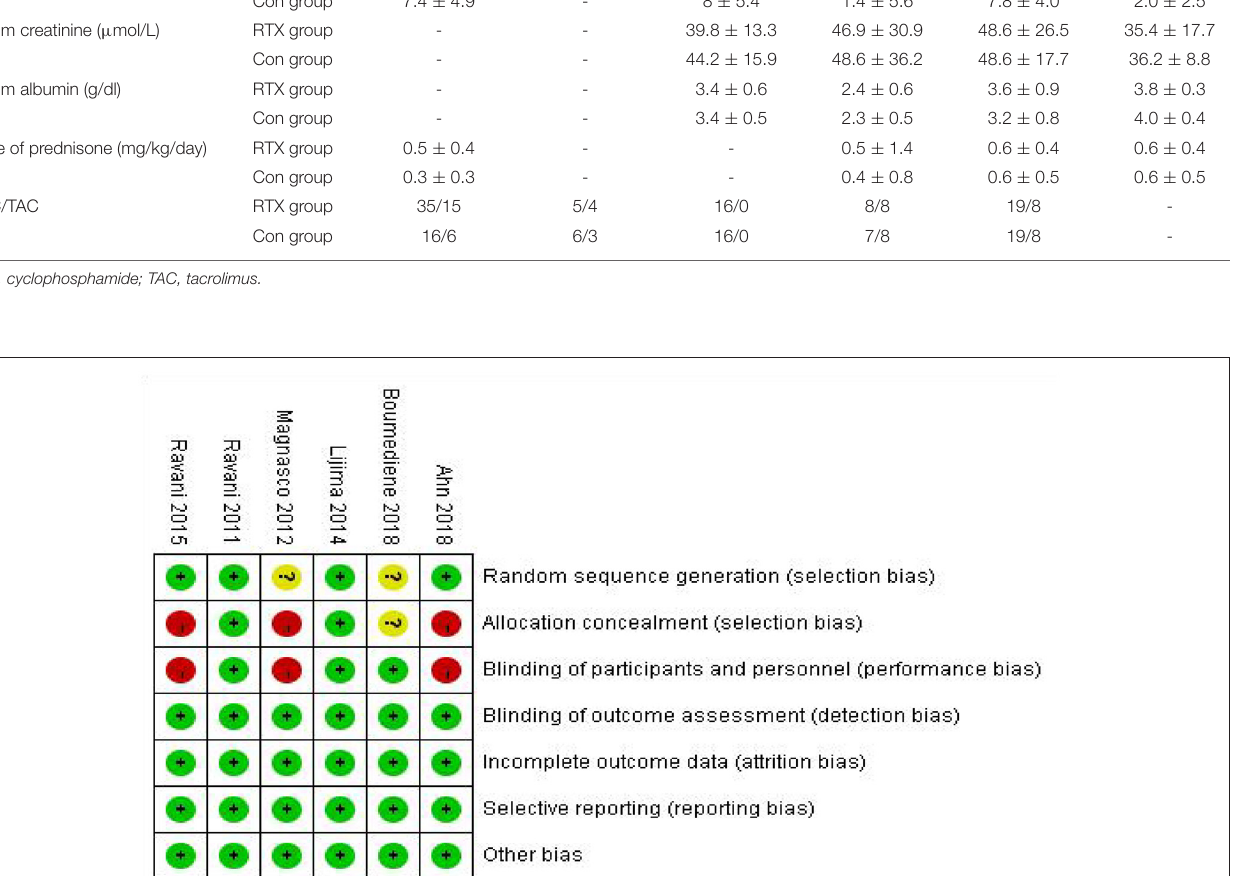
(124 children) and the control group (110 children). We found that when compared to that in control, RTX could reduce the relapse number of NS, the use of steroids or/and calcineurin inhibitors, and the dosage of steroids, while RTX could not decrease the protein excretion. There were fewer reports of serious adverse reactions of RTX during the therapy, and most adverse events were mild and could be alleviated after stopping RTX or reducing the infusion